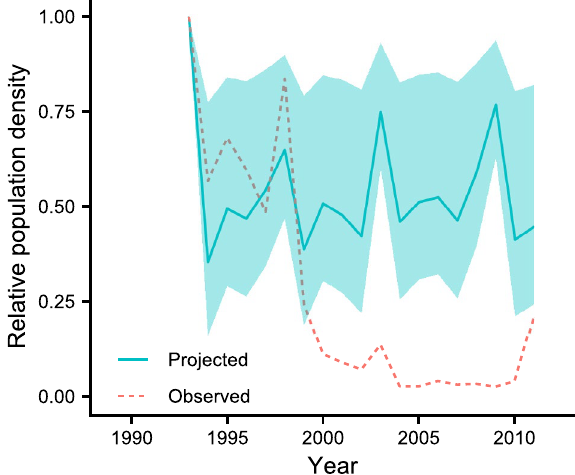
Figure 3. Relative population densities of Sympetrum frequens projected by using the estimated coefficient of the regression analysis (Model 1) and the temperature data of AMGSD (—), and the observed relative abundance (- - -) in Toyama Prefecture. The shaded zone represents the range of projected relative population densities calculated by using the upper and lower limits of the 95% confidence interval of the estimated coefficients. The observed data come from Futahashi